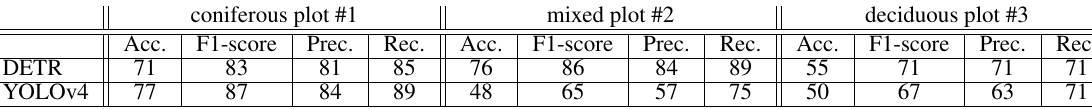
Table 4. Results of tree detection with DETR and YOLOv4 in test plots #1, #2 and #3. Numbers in percent.